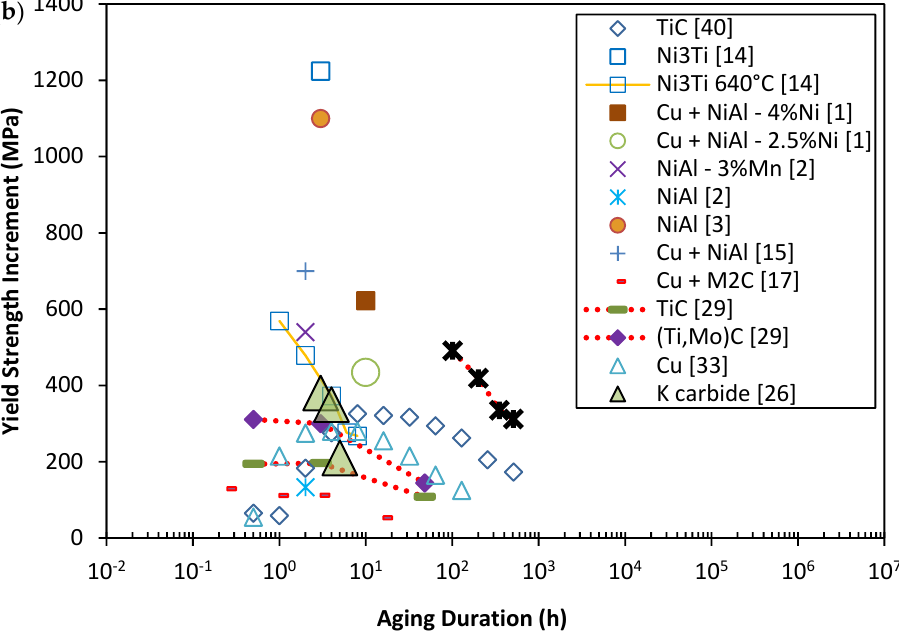
Figure 10. The ( a ) size of various precipitates in steels and ( b ) the corresponding changes in yield strength after prolonged aging at different temperatures. Data points with red dots indicate annealing temperatures of above 700 °C; Data points with a yellow line represent annealing temperatures between 600 and 700 °C; Data points with no marking denote annealing temperatures between 500 and 600 °C.